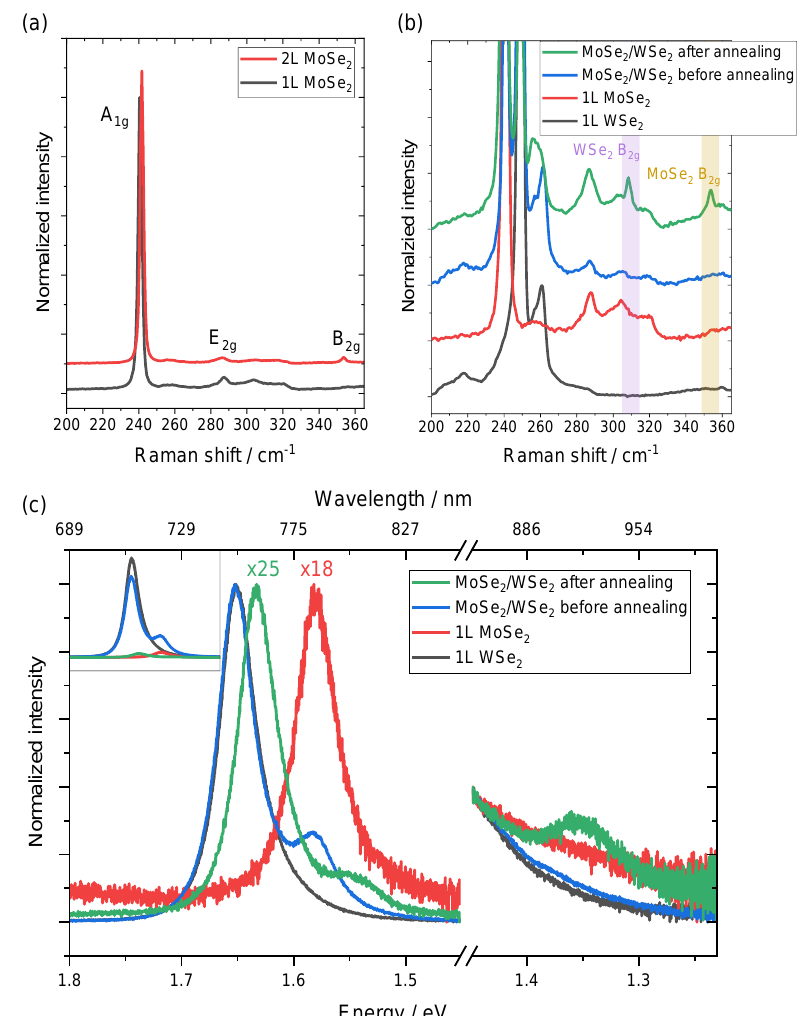
Figure 4. ( a ) Raman spectra of monolayer and bilayer MoSe 2 . ( b ) Raman and ( c ) PL spectra of monolayer WSe 2 , MoSe 2 , and MoSe 2 /WSe 2 hetero-bilayer before and after annealing. The spectra between 1.80 eV and 1.45 eV are normalized from 0 to 1, and the spectra between 1.45 eV and 1.23 eV are normalized from 0 to 0.4 for better visualization. Inset: as-measured (not-normalized) PL